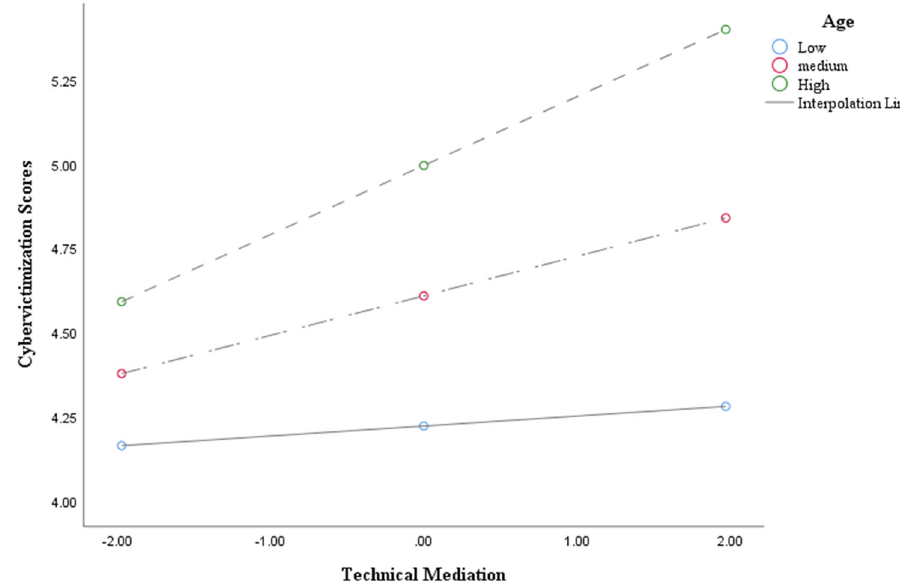
Fig. 2 Graphical representation of three-way interaction between technical mediation, age, and gender for cybervictimization.